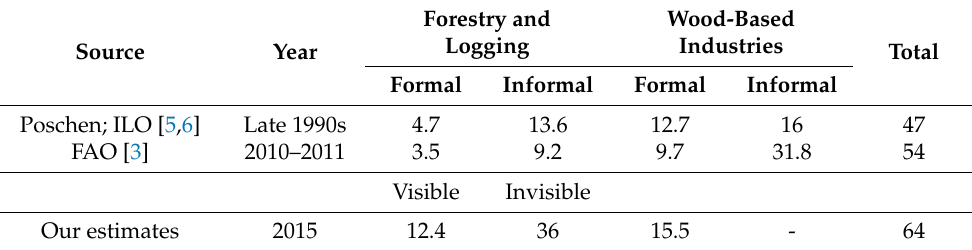
Table 5. Comparison our employment estimates (million-person FTE) with the prior studies.